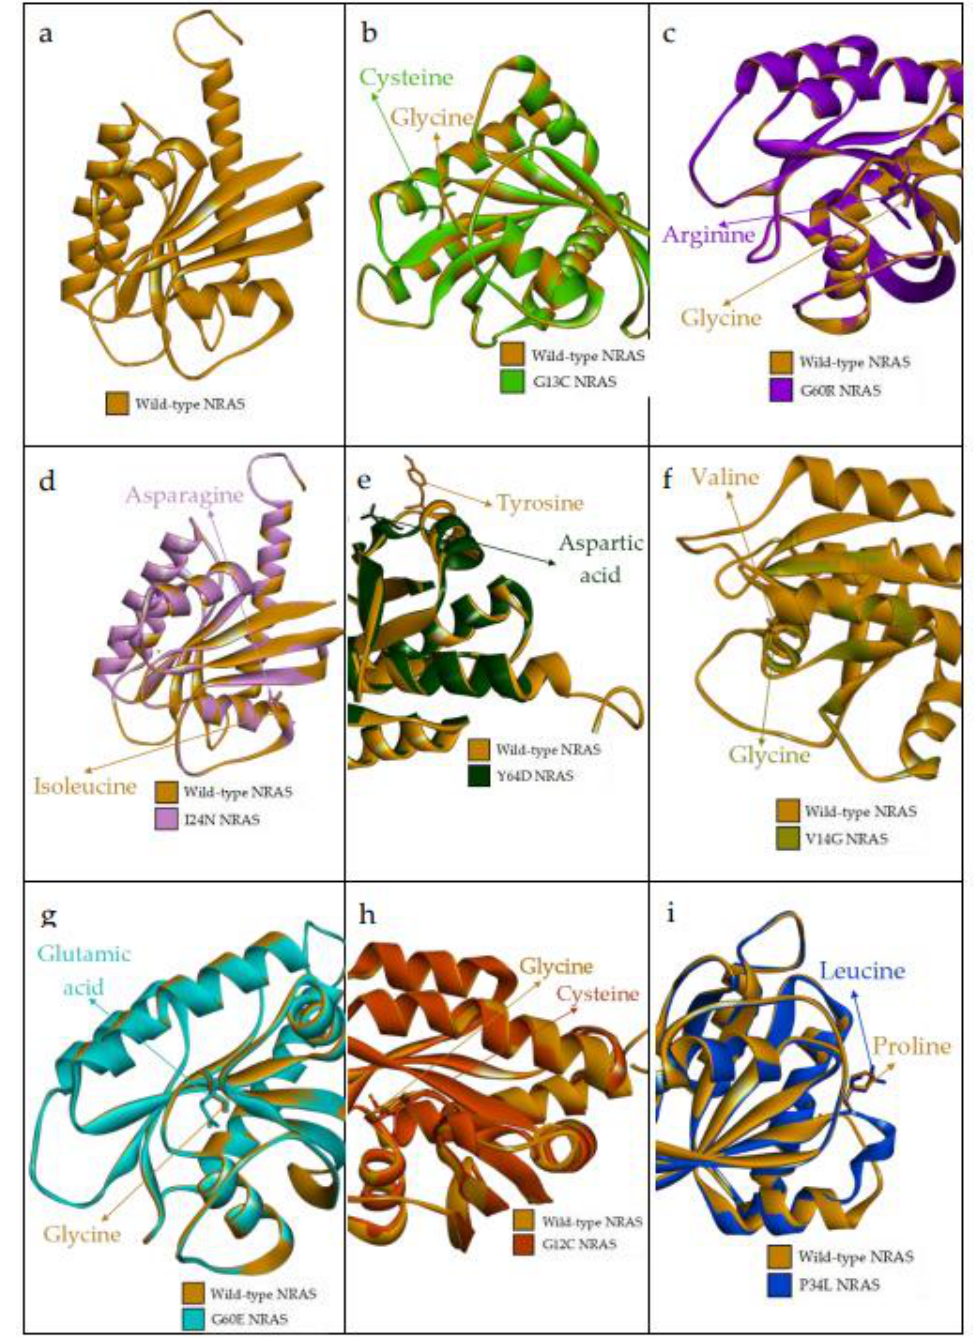
Figure 4. 3D protein structure of superimposed wild-type NRAS and its mutated protein predicted by SWISS-MODEL. ( a ) The 3D structure of wild-type NRAS protein; ( b ) superimposed structure of wild-type NRAS protein with mutated I24N NRAS protein; ( c ) superimposed structure of wild-type NRAS protein with mutated G60E NRAS protein; ( d ) superimposed structure of wild-type NRAS protein with mutated G13C NRAS protein; ( e ) superimposed structure of wild-type NRAS protein with mutated Y64D NRAS protein; ( f ) superimposed structure of wild-type NRAS protein with mutated V14G NRAS protein; ( g ) superimposed structure of wild-type NRAS protein with mutated G60R NRAS protein; ( h ) superimposed structure of wild-type NRAS protein with mutated G12C NRAS protein; ( i ) superimposed structure of wild-type NRAS protein with mutated P34L NRAS protein.